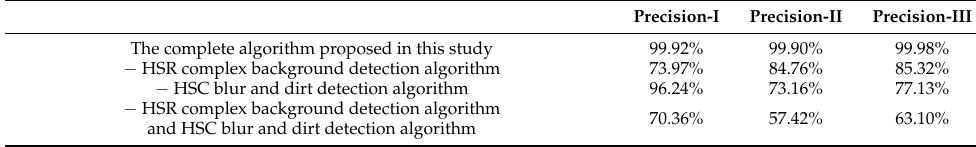
Table 6. Impact of different modules on the overall